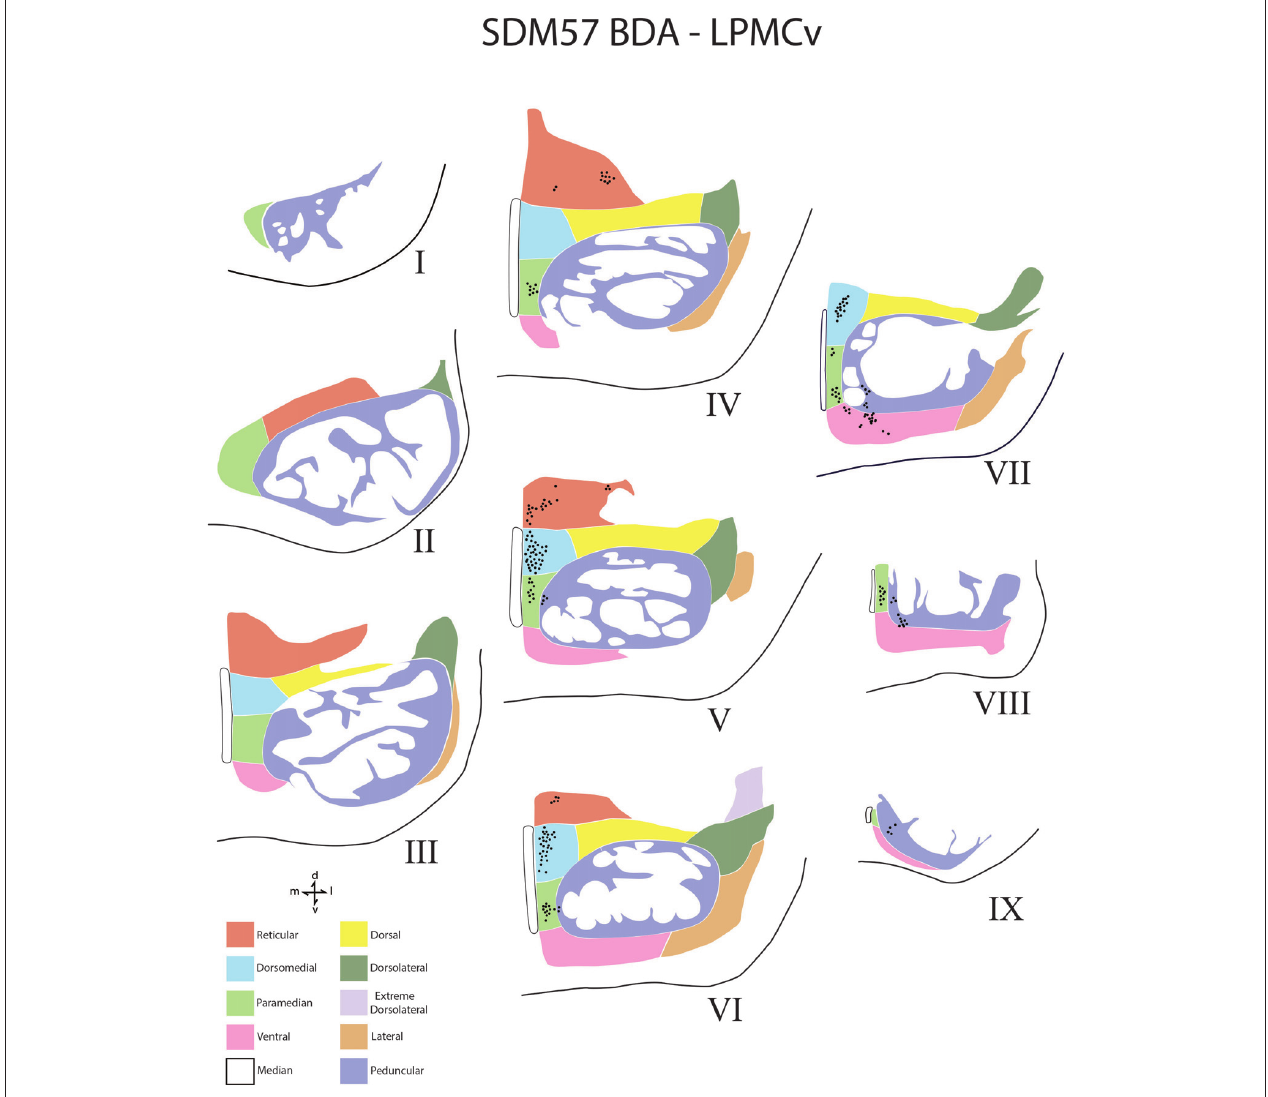
FIGURE 6 | Line drawings of transverse sections depicting the topographical distribution of labeled terminals (black dots) from superior (I) to inferior (IX) levels of the basis pontis in case SDM57 following an injection of BDA into the dorsal region of LPMCv. Note terminal labeling is nearly exclusively located in the medial pontine region and at middle and inferior pontine levels. Abbreviations: d, dorsal; l, lateral; m, medial; v,